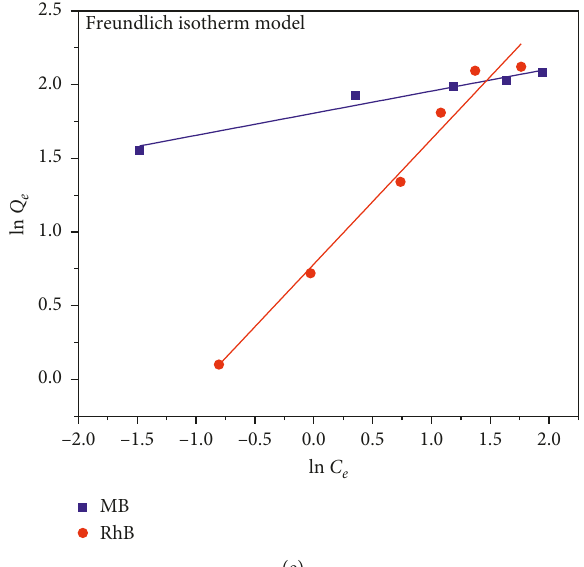
Figure 11: Kinetic and sorption models describing the adsorption process. (a) Pseudo-first order. (b) Pseudo-second order. (c) Intraparticle. (d) The Langmuir and (e) Freundlich